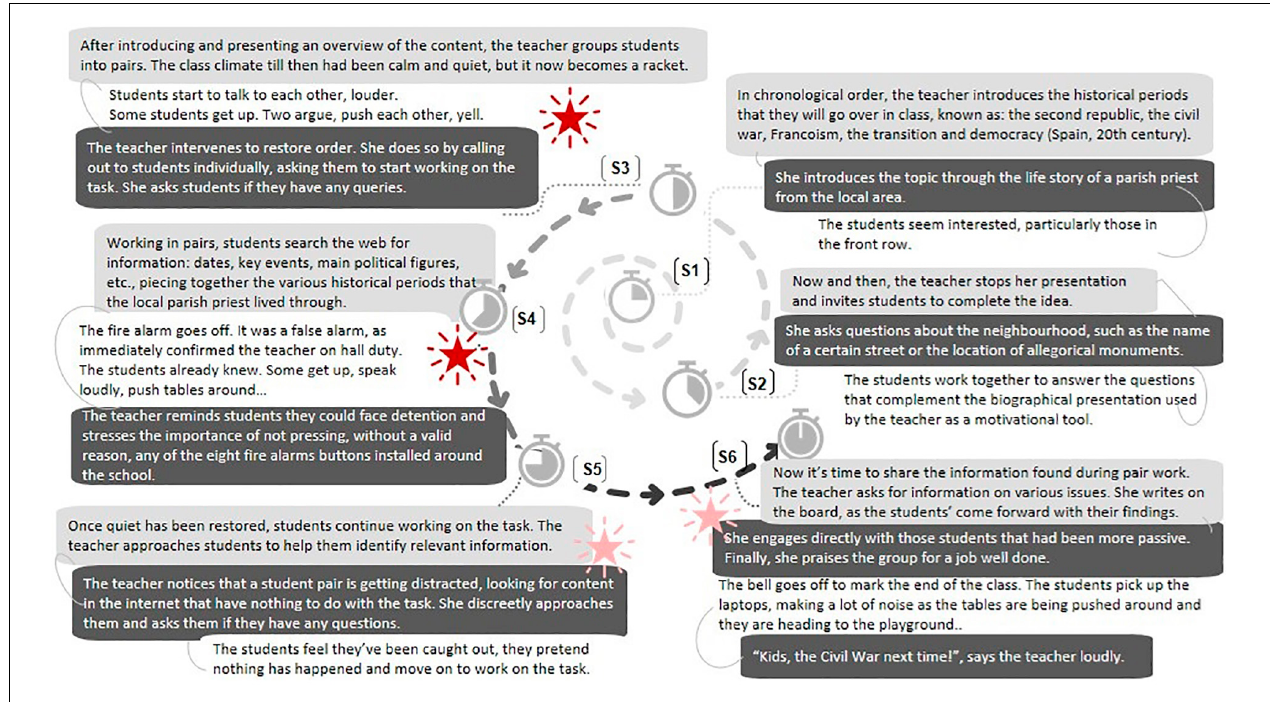
FIGURE 3 | Causal network: Case B “The story of the local parish priest.”